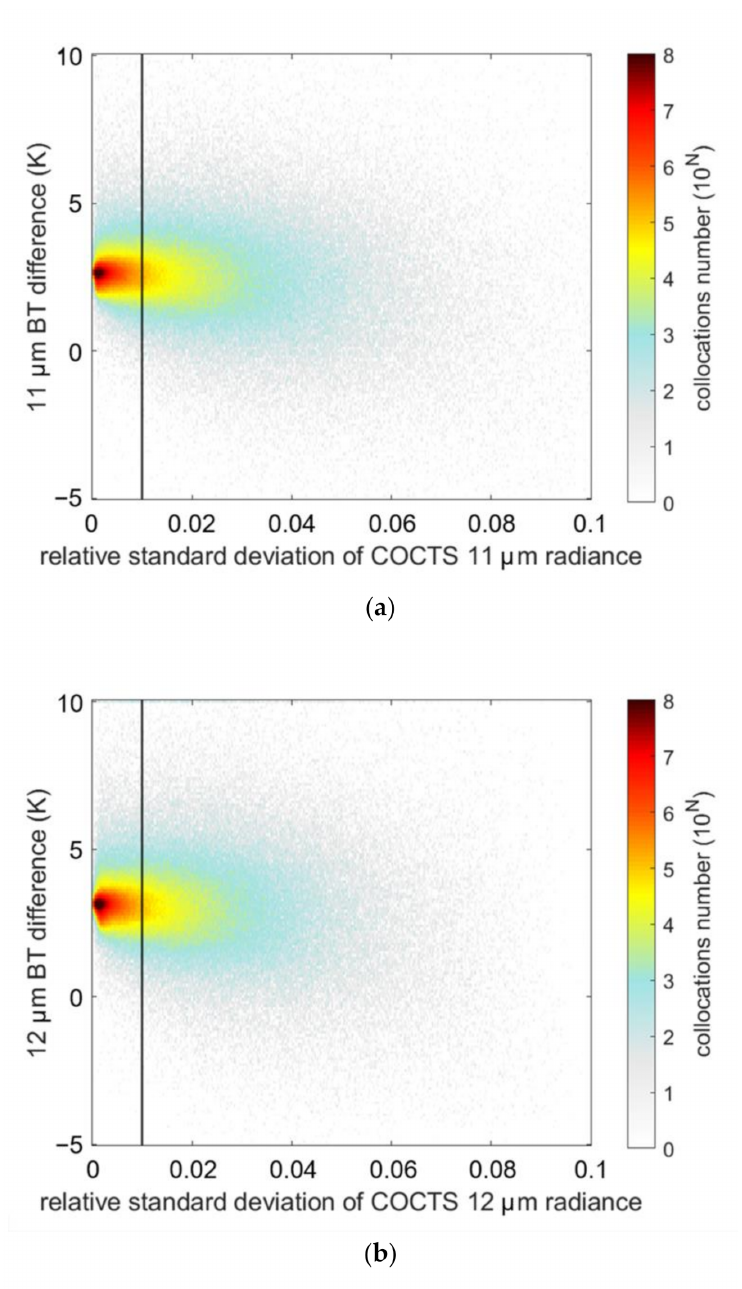
Figure 3. The distribution of the HY-1C COCTS minus IASI BT differences against the RSDs of the HY-1C COCTS radiance in the collocated grids: ( a ) 11 µ m channel; ( b ) 12 µ m channel. 4. Comparison Results of the HY-1C COCTS Thermal Infrared BTs with